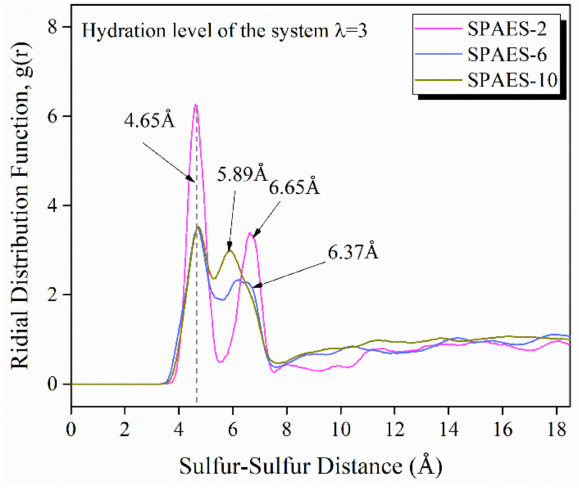
Figure 5. RDFs of sulfur–sulfur for the membrane with various lengths of side chains at hydration level of λ = 3.